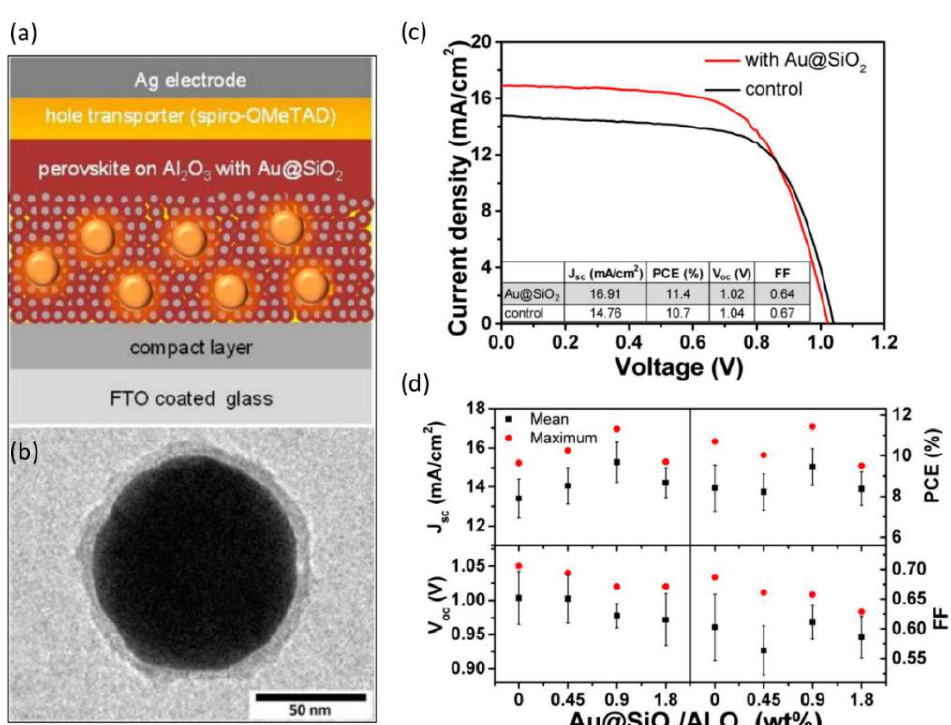
Figure 12. ( a ) Illustration of device structure with. ( b ) Typical TEM micrograph of Au@SiO 2 NPs. ( c ) J–V plots for Al 2 O 3 -only and Au@SiO 2 devices measured under STC. ( d ) Load dependence of Au@SiO 2 NPs on the device performance. Reproduced with permission from Ref.